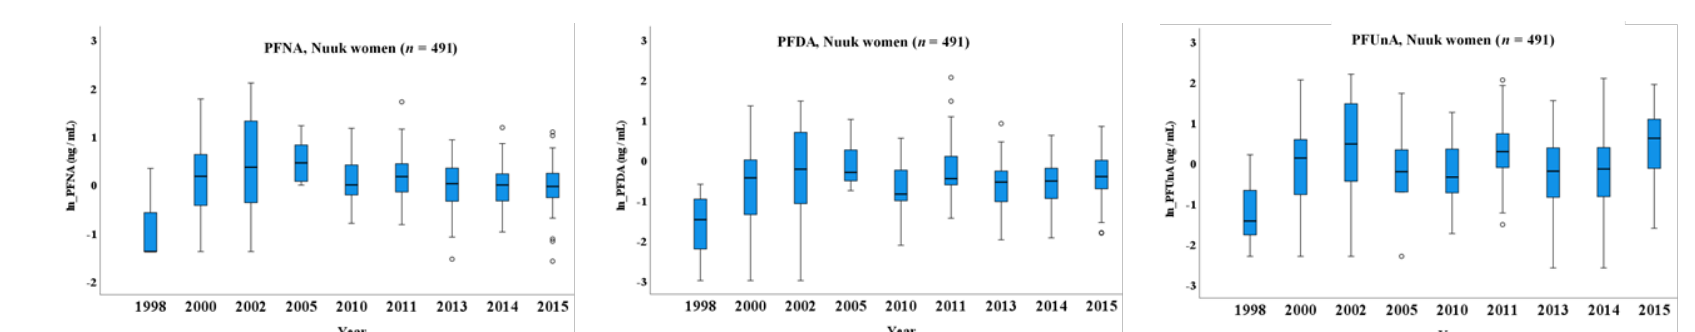
Figure 2. The time trend of lipPOPs, metals and PFASs in Nuuk women during 1998 – 2015. The boxes display the 25th and 75th centiles, and the line inside the boxes represents the median value. The whiskers display the lower and upper values within 1.5 times the interquartile range beyond the box. Outliers are marked with dots. The data were raw data and in ln-transformed scale. The figure in normal scale is given as Figure S1. Please see Table 2 for the adjusted data. LipPOP: legacy lipophilic POPs; PFASs: perfluoroalkylated substances. For the full name of chemicals, please refer to abbreviation list. Table 3. Women in Nuuk and Ilulissat: Time trend of lipPOPs, metals and PFASs level.